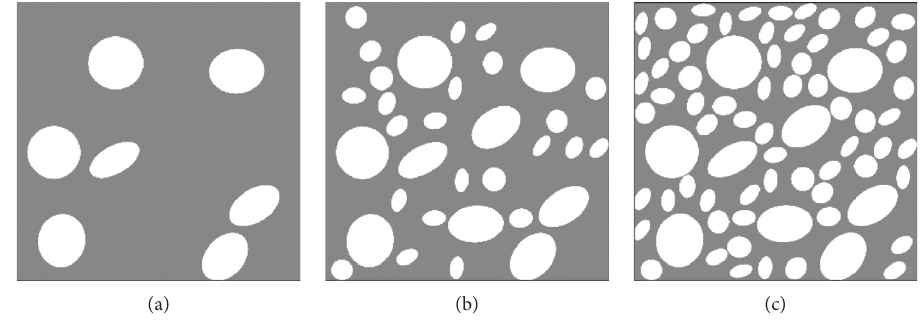
Figure 1: Generation process of coarse aggregates in the random-aggregate